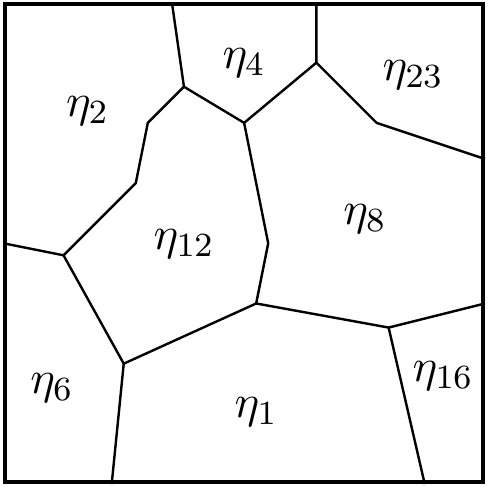
Schematic representation of a grain microstructure using the orientation parameters η . Grain boundaries are indicated with solid k